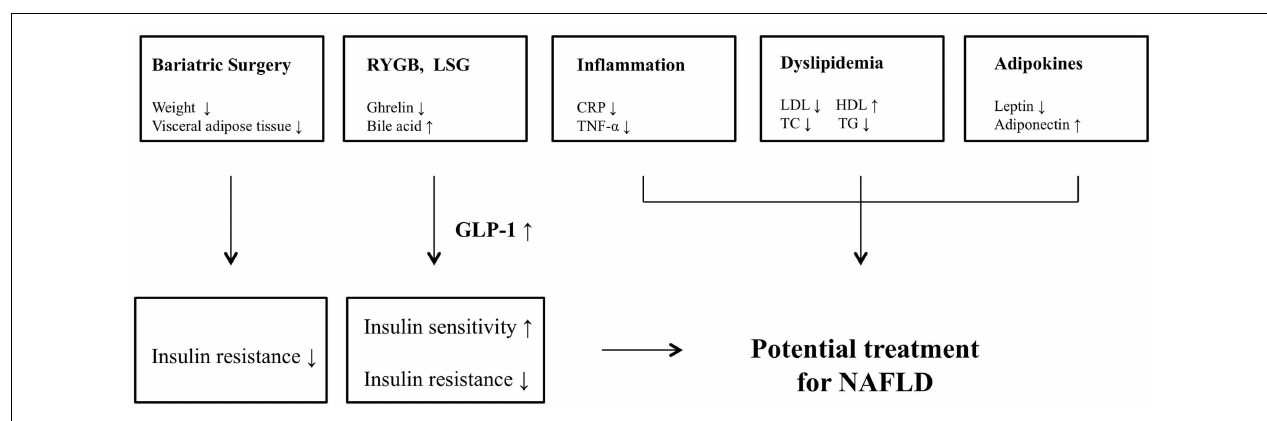
FIGURE 1 | Potential mechanisms or improvement for NAFLD after bariatric surgery